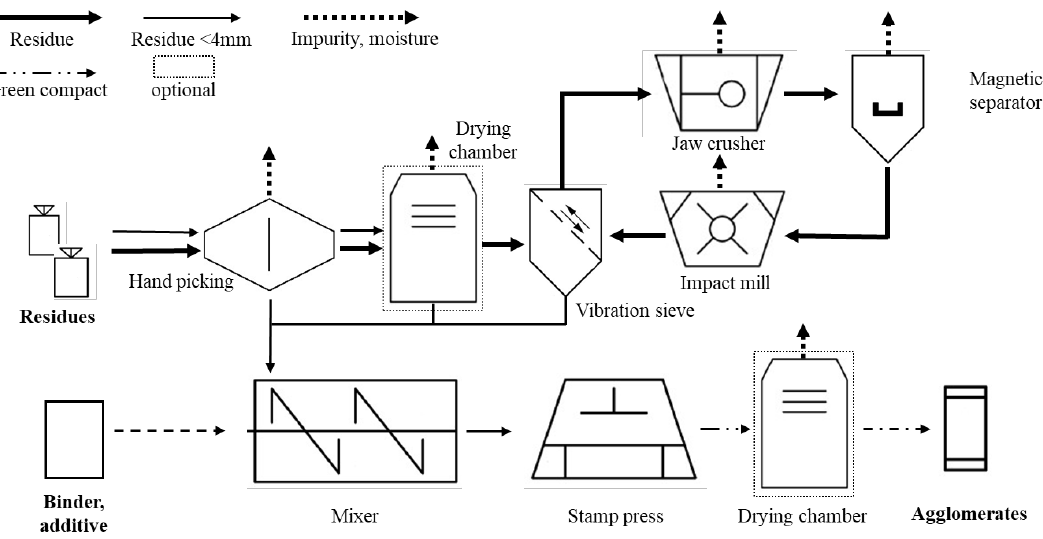
Figure 1. Chart of the manufacturing process.